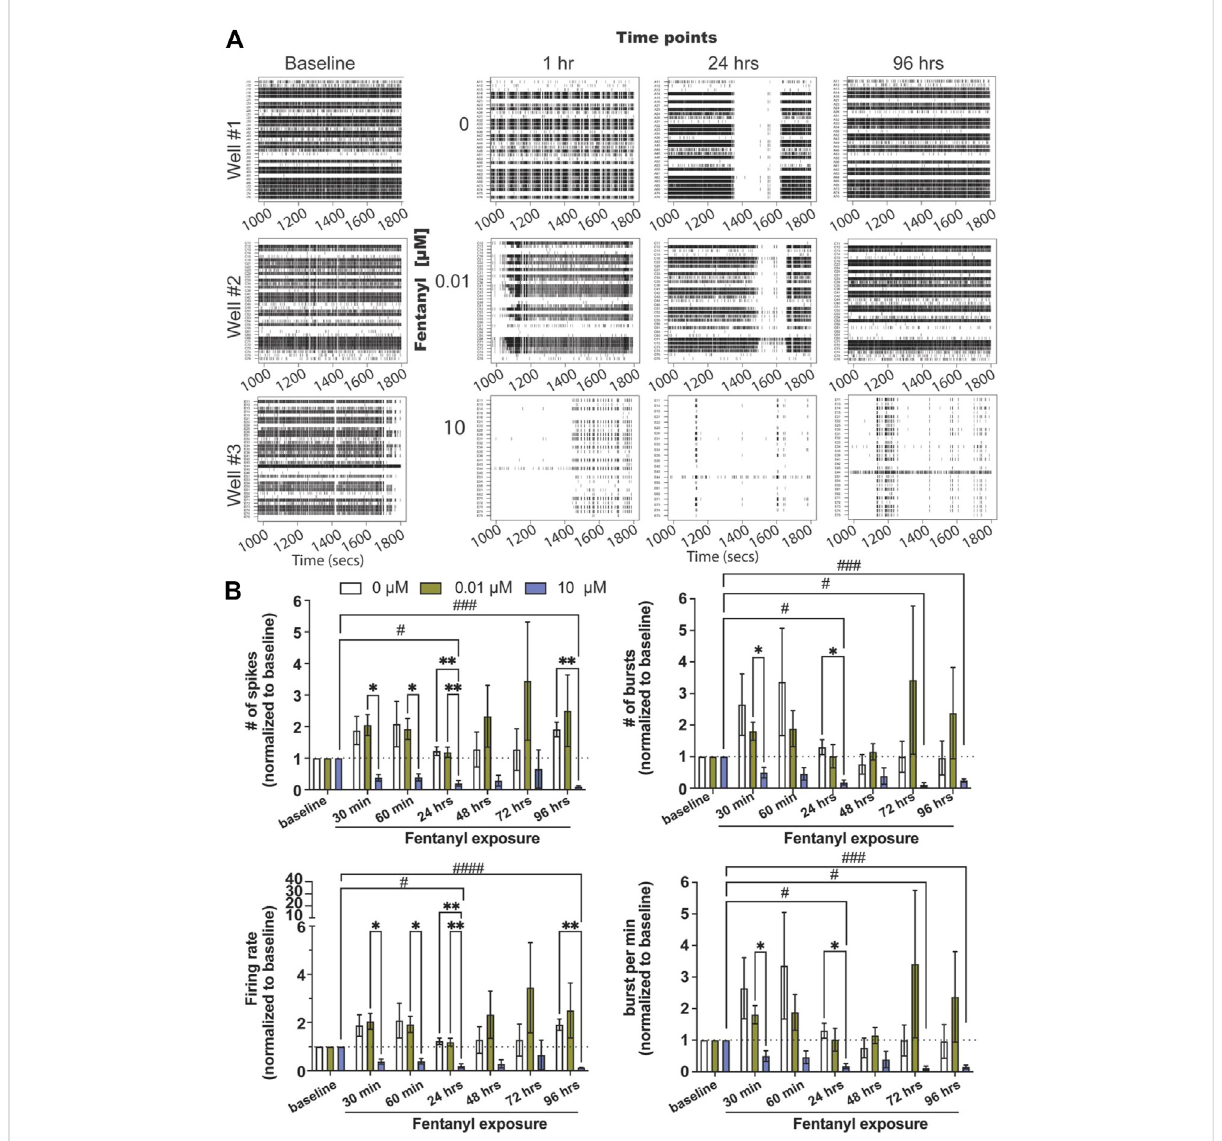
FIGURE 1 Neural and network activity from complex cultures before and during sub-chronic fentanyl exposure. (A) Representative 1800 ms raster plots showing spiking and bursting activity for each electrode (row) before (e.g., baseline) and at 1, 24, and 96 h of exposure to fentanyl at 0, 0.01, and 10 μ M. (B) Bar graph summarizes the features of spiking (e.g., number of spikes and fi ring rate, left column) and bursting (number of bursts and burst per minute, right column) before and during sub-chronic fentanyl exposure ( n = 5 – 7 wells/treatment condition). Data is normalized to treatment-condition at baseline (dotted line at 1), shown as mean ± SEM, and was analyzed using repeated measures two-way ANOVA with Tukey ’ s posthoctest.Statisticalsigni fi cancesareobservedwhencomparingacrosstreatmentconditions(*)andacrosstimepoints(#)atalevelof# p < 0.05, ## p < 0.01, ### p < 0.001, and #### p < 0.0001 for the number of symbols